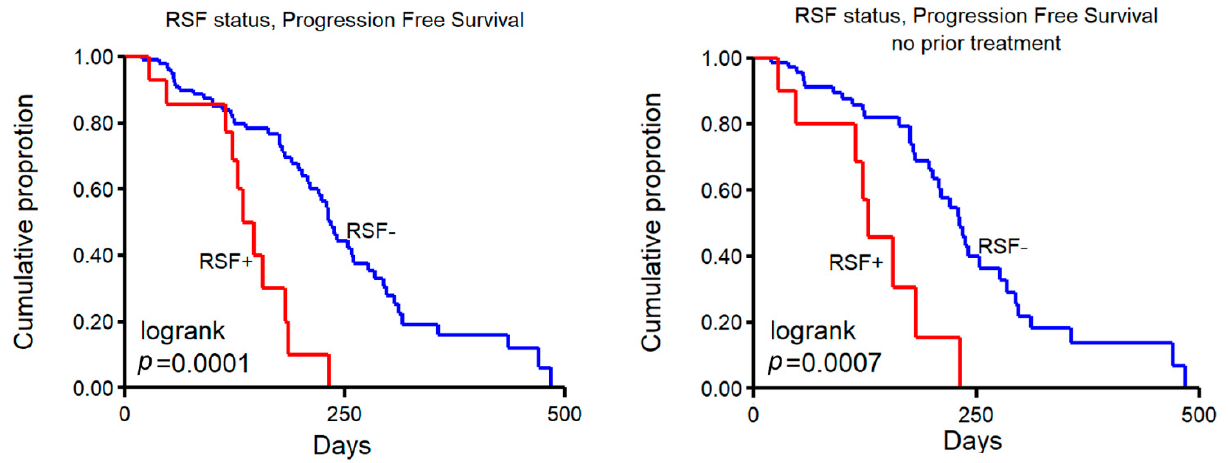
Figure 6. Number of DELs and progression-free survival. Kaplan–Meier progression-free survival curves of patients treated with platinum-containing therapy. Samples were grouped in those >20 DELs, labeled as resolved stalled fork positive (RSF+) vs. <20 (RSF-). Left panel shows all patients, and right panel shows patients with no prior therapy.